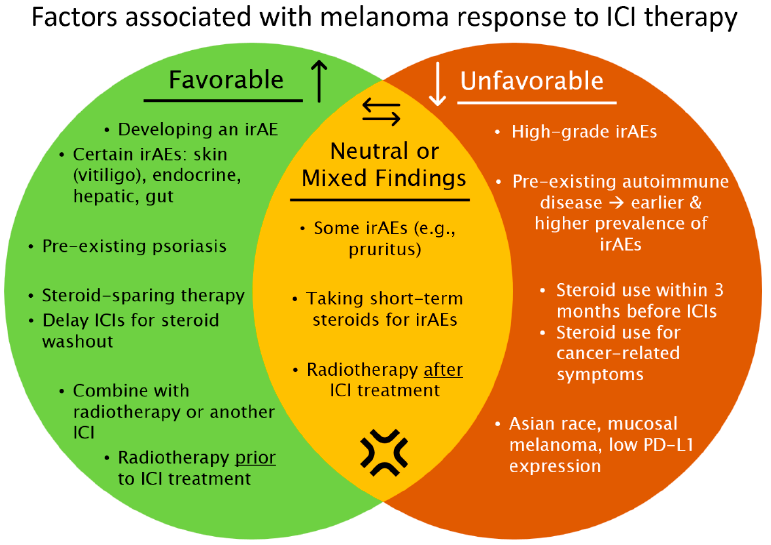
Figure 1. A summary of factors associated favorably and unfavorably with melanoma response to immune checkpoint inhibitor (ICI) therapy. irAE = immune-related adverse